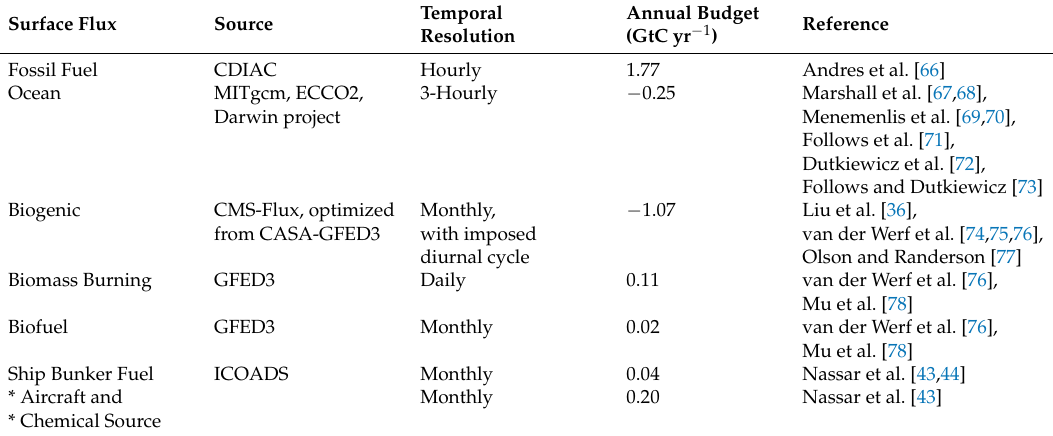
Table 1. Surface fluxes for the North American domain in this